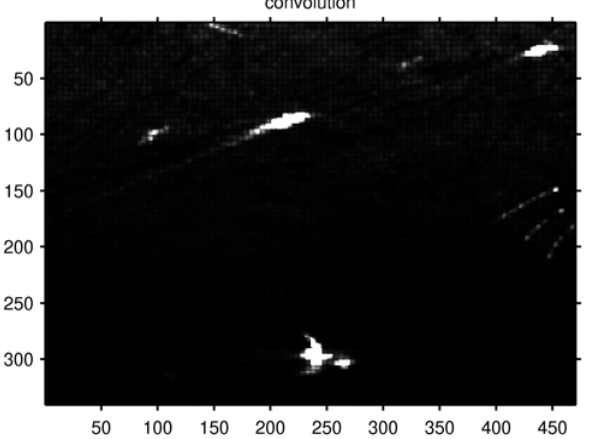
Figure 12. The span image after convolution of AIRSAR